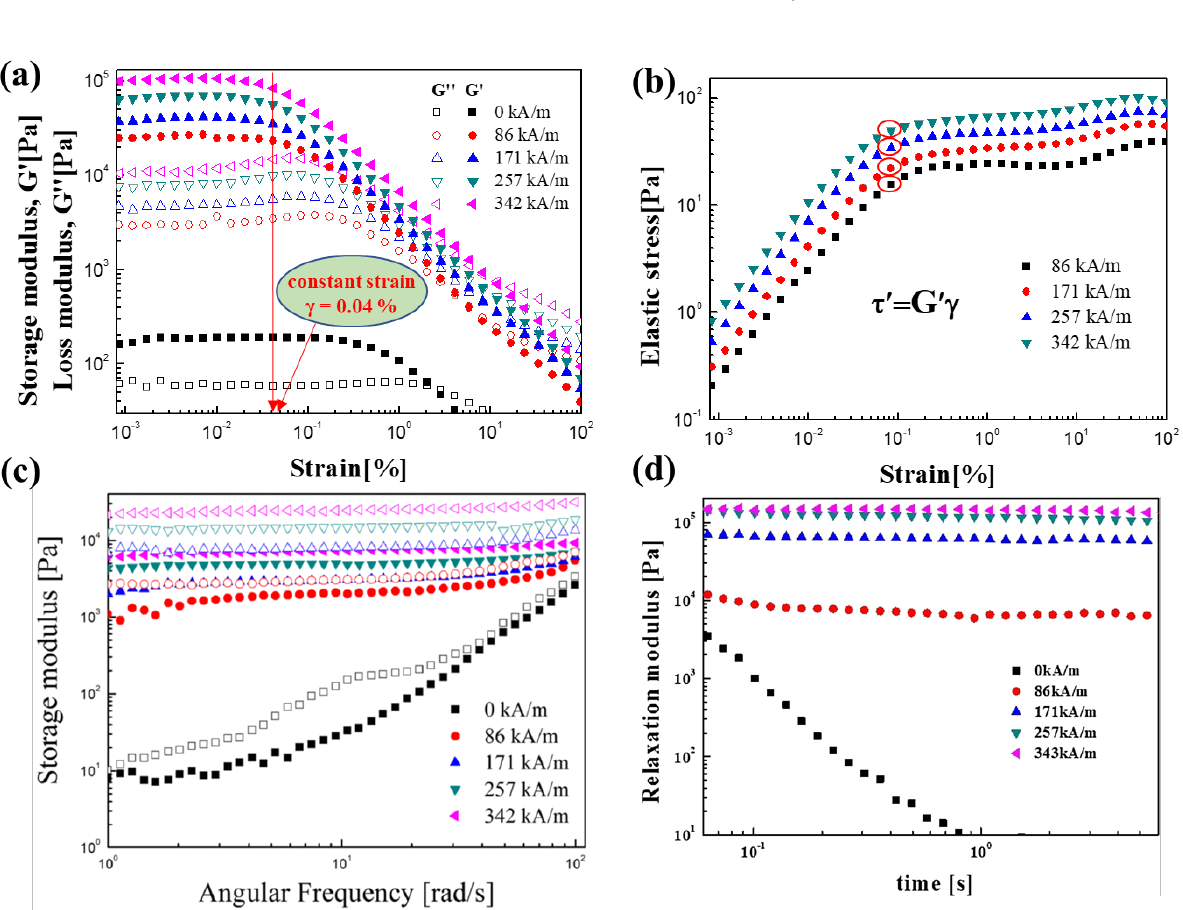
Figure 7. Strain amplitude sweep for an Fe 3 O 4 -PS-composite-based MR fluid (10 vol %, 100 cSt silicone oil) as a function of ( a ) storage modulus vs. strain and loss modulus vs. strain (closed symbols: G (cid:48) ; open symbols: G (cid:48)(cid:48) ) and ( b ) elastic stress vs. strain (Gao et al. [48], ©Springer Nature, 2017). ( c ) Storage modulus of pure Fe 3 O 4 (open) and PANI@Fe 3 O 4 (closed) as a function of the angular frequency (Kwon et al. [53], ©IEEE, 2016). ( d ) Relaxation modulus of CI/PANI calculated from G (cid:48) ( ω ) and G (cid:48)(cid:48) ( ω ) obtained from a frequency sweep test (Min et al. [64], ©Elsevier B.V.,